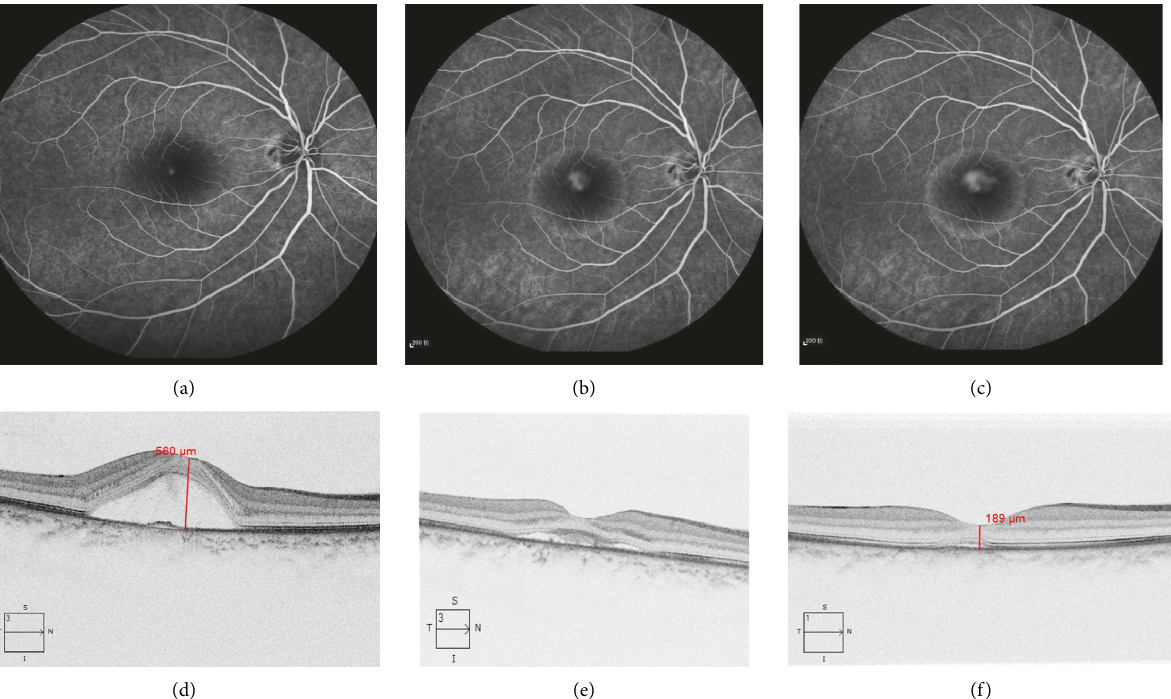
Figure 1: A 40-year-old male patient who underwent SMTL. (a–c) FFA showed the right eye macular subfoveal fluorescein leakage at the early phase stage, and dye formed an umbrella pattern of fluorescein pooling in the subretinal space at the late phase stage. (d) OCTshowed the baseline serous macular retinal detachment combined with mini RPE detachment before SMTL. (e, f) Macular subretinal fluids partially and incompletely absorb post SMTL follow-up one and three